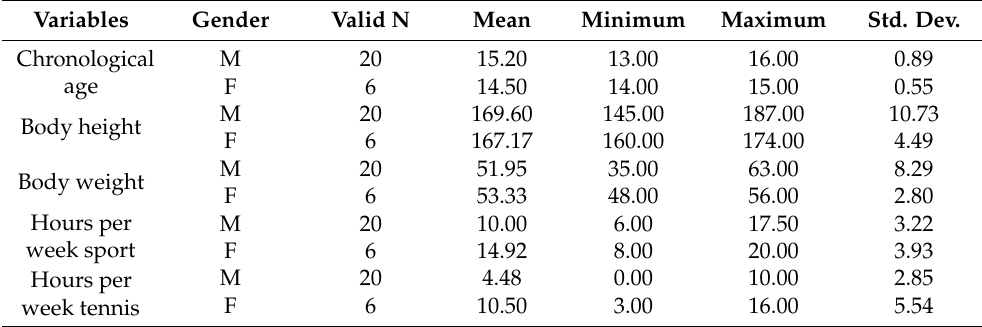
Table 1. Descriptive statistics of ball kids participating at the French Open, Roland Garros